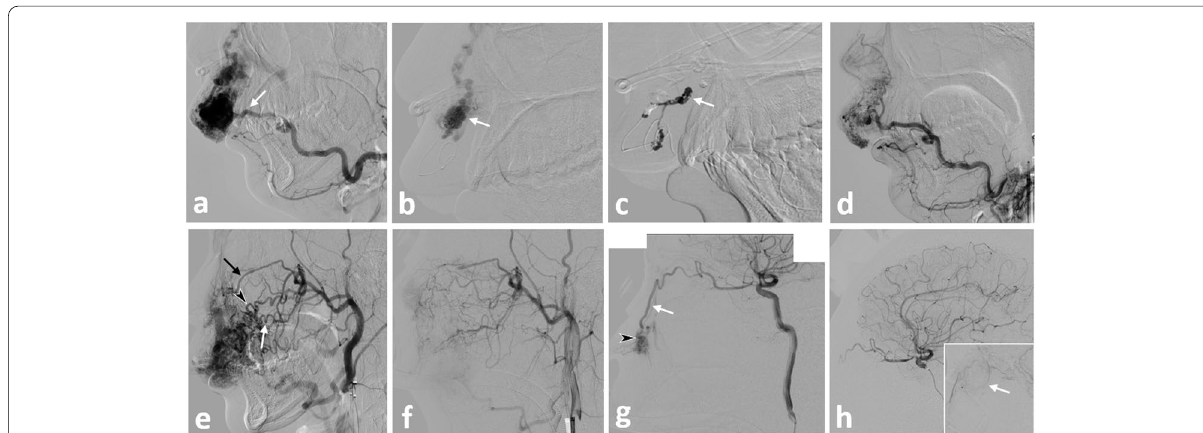
Fig. 1 Angiograms in Case 1 showing high-flow AVMs with multiple shunts between the arterioles and venules as a complex vascular network (Cho’s classification type IIIb) in the left upper lip and cheek. The AVMs were fed by bilateral FAs and the left ICA and drained into bilateral facial and angular veins. a Right facial arteriogram, lateral view, before the first embolization session. Arrow indicates the right SLabA. b Pre-embolization left external carotid arteriogram before the first session. The microcatheter was navigated to the distal feeder from the right SLab A (arrow). c DSA, lateral view, during injection of nBCA under flow control. The nBCA-lipiodol mixture filled the shunting points and the distal draining veins (arrow). d Left external carotid arteriogram after embolization of the right FA after the second session showing devascularization of the AVM. e External carotid arteriogram, lateral view, after embolization of bilateral Slab As showing residual AVMs fed by the IOA (black arrow), greater palatine artery (white arrow), and transverse FA (arrowhead). f Left external carotid arteriogram after embolization of the left IOA from the left MA during the fifth session showing disappearance of the AVM. g Pre-embolization left internal carotid arteriogram during the fifth session. Arrow indicates the angular (lateral nasal) artery originating from the ophthalmic artery. Microcatheter was navigated into distal segment of the feeding artery (arrowhead). h Post-embolization after the fifth session. Left internal carotid arteriogram showing disappearance of the AVM without distal embolism into the cerebral artery and retinal artery (arrow: preserved retinal blush on a magnified image during the venous